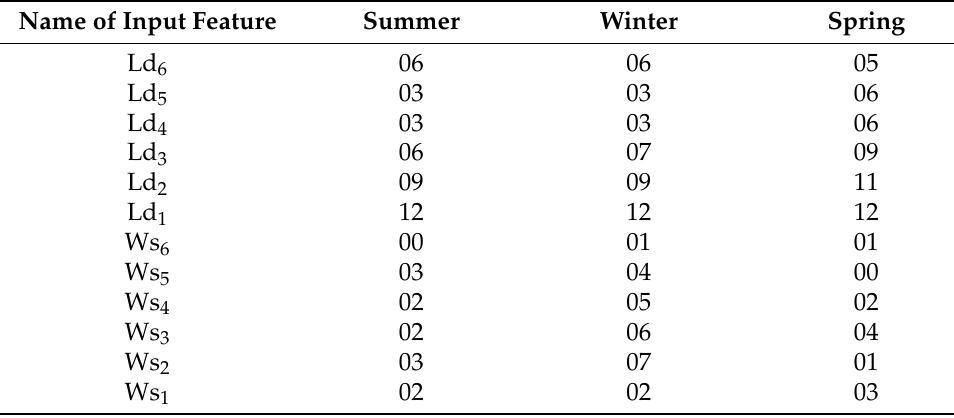
Table 4. Input feature is selected (season-wise) for